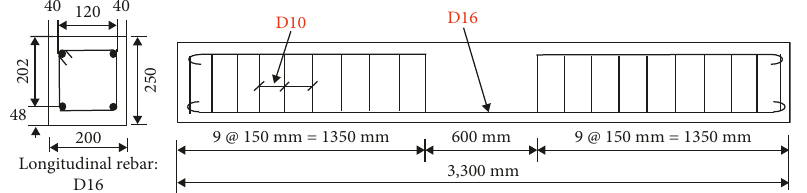
Figure 4: Dimensions of the beams.